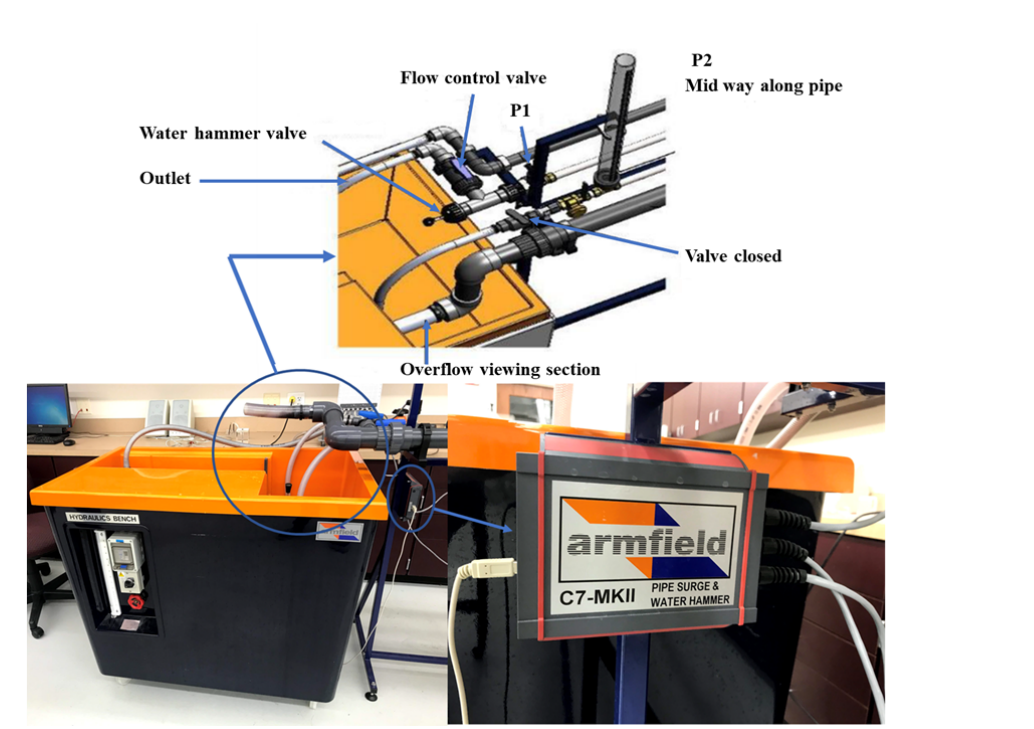
Figure 3. Components associated with the water hammer effect